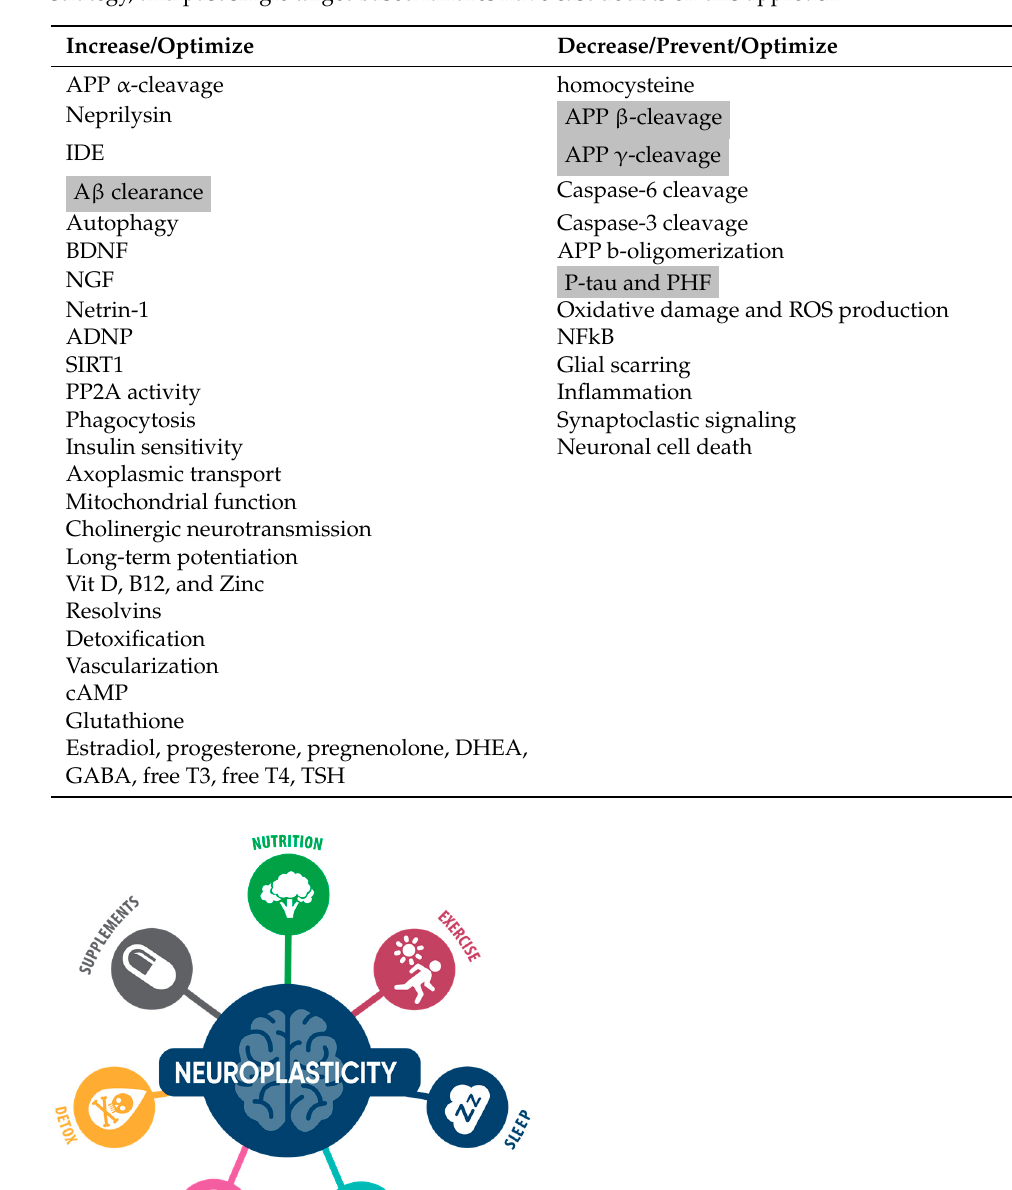
Table 1. Criteria for a perfect AD drug. A perfect drug is one that increases and optimizes all parameters on the left as they tend to be lowered or down-regulated in AD. The same drug decreases, lowers, or reduces the parameters on the right side, as these tend to be elevated in AD. The highlighted items indicate the targets of preference for most pharmaceutical companies. While some drugs are designed to target amyloid, others are focused on tau. However, here again, it is a mono-therapeutic strategy, and past single target-based failures have cast doubts on this approach.